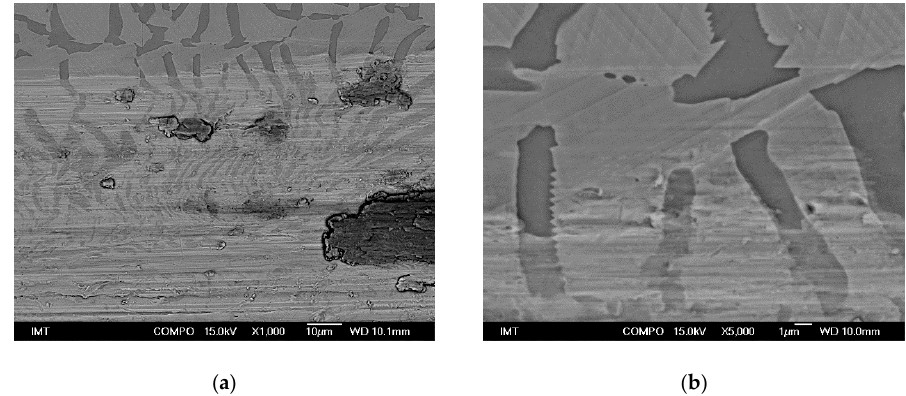
Figure 11. SEM-BSE images of wear tracks of AlCoCrFeNi 2.1 CCA in as-the cast state: ( a ) Wear track edge with patches of re-deposited material; ( b ) Slip lines in the vicinity of wear track.